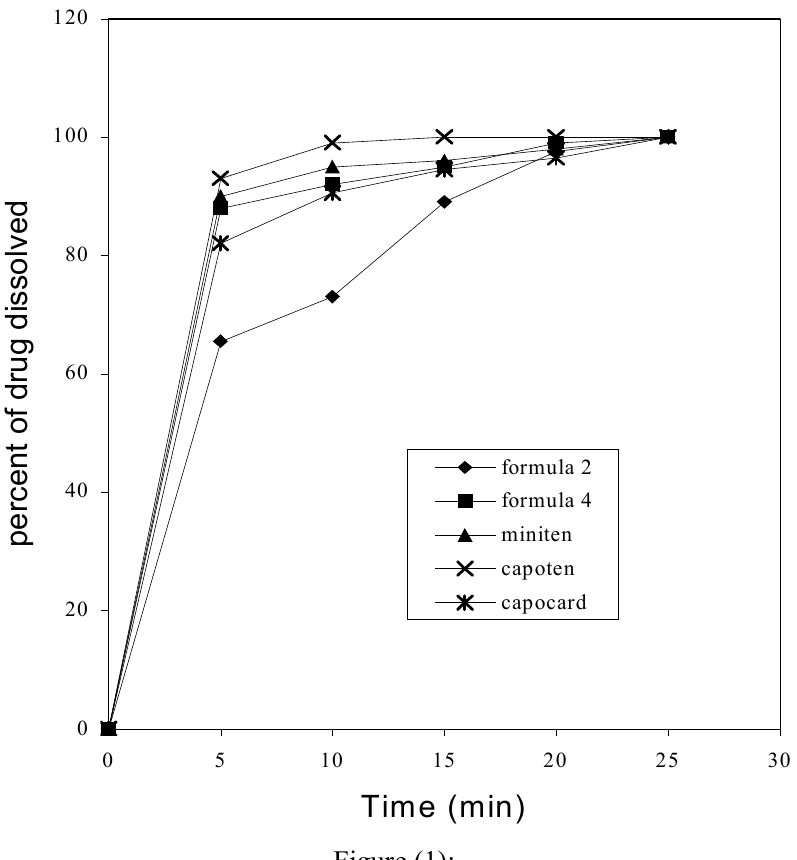
Release study for formula (2) and (4) in comparison with reference formulas in 0.1N HCl and 37  C.